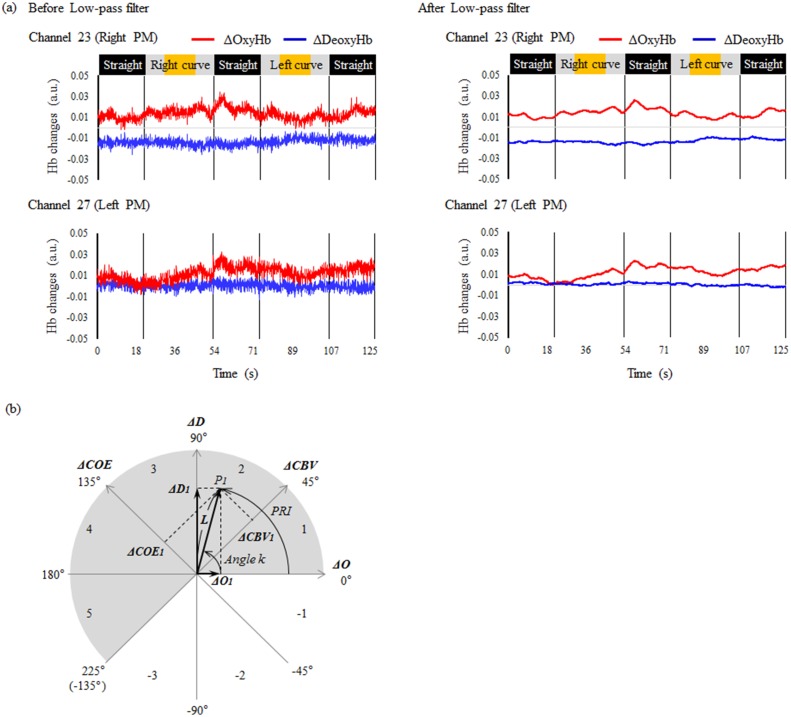
Time-series waveforms of ΔOxyHb and ΔDeoxyHb, and a ΔO/ΔD vector plane.(a) Raw waveform data for changes in oxyhemoglobin and deoxyhemoglobin (ΔOxyHb and ΔDeoxyHb) from the right PM (channel 23) and the left PM (channel 27). These channels are symmetrical regions of the cerebral cortex. Frequencies of more than 0.1 Hz were removed from the raw data using a low-pass filter. Straight sections of the course are indicated in black, easement curves in gray, and circular curves in orange. PM = premotor cortex. (b) Vector trajectories on this polar coordinate plane make it possible to visually evaluate relationships between changes in the cerebral blood volume vector component (ΔCBV) and the cerebral oxygen exchange vector component (ΔCOE).